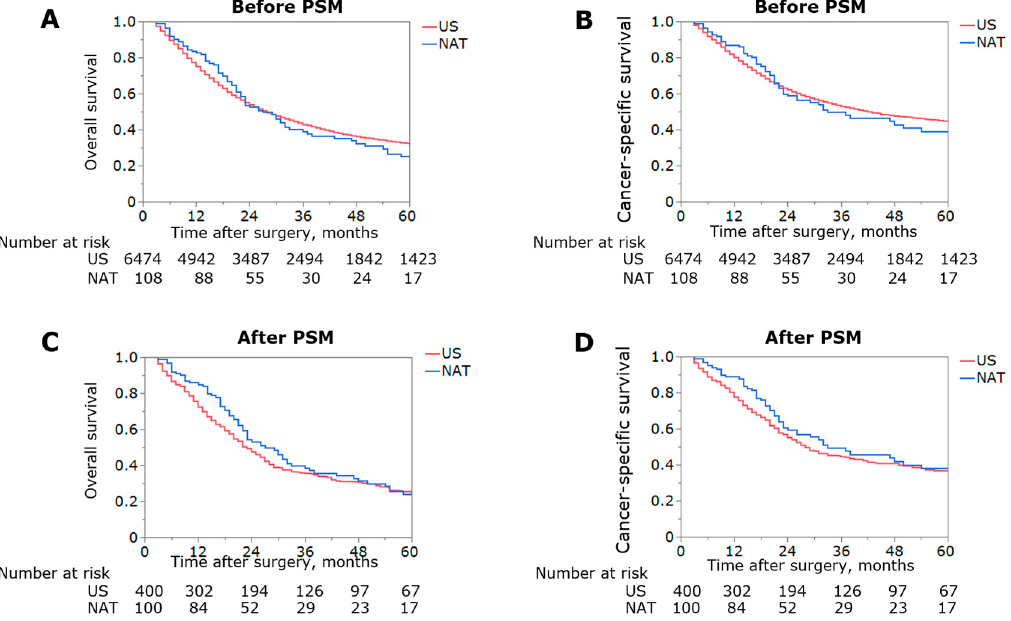
Figure 2. Kaplan–Meier curves depicting overall ( A , C ) and cancer-specific survival ( B , D ) among patients with extrahepatic biliary tract cancer before and after propensity score matching, respectively. Table 2. Univariate and multivariate Cox regression analyses with OS and CSS among propensity score-matched patients with extrahepatic biliary tract